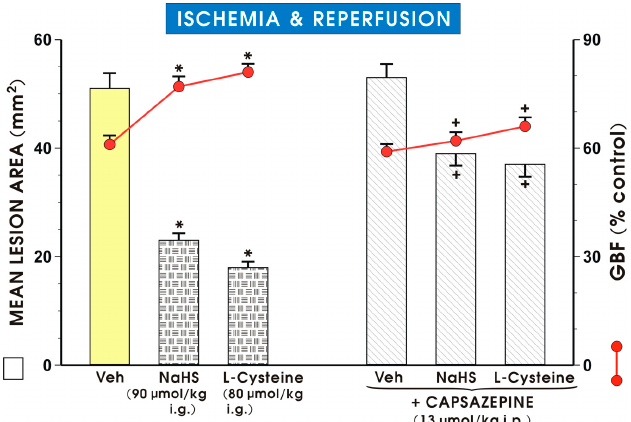
Figure 4. Mean lesion area and the GBF in rats pretreated with vehicle, NaHS (90 μ mol/kg i.g.) or L -cysteine (80 μ mol/kg i.g.) alone or in combination with capsazepine (13 μ mol/kg i.p.) and exposed to I followed by 3 h of R. Results are mean ± S.E.M of 4–5 per each experimental group. Significant changes as compared with the respective values in the vehicle-control group are indicated by an asterisk ( p < 0.05). A cross indicates a significant change compared to the values obtained in the group treated with NaHS and L -cysteine alone ( p < 0.05).